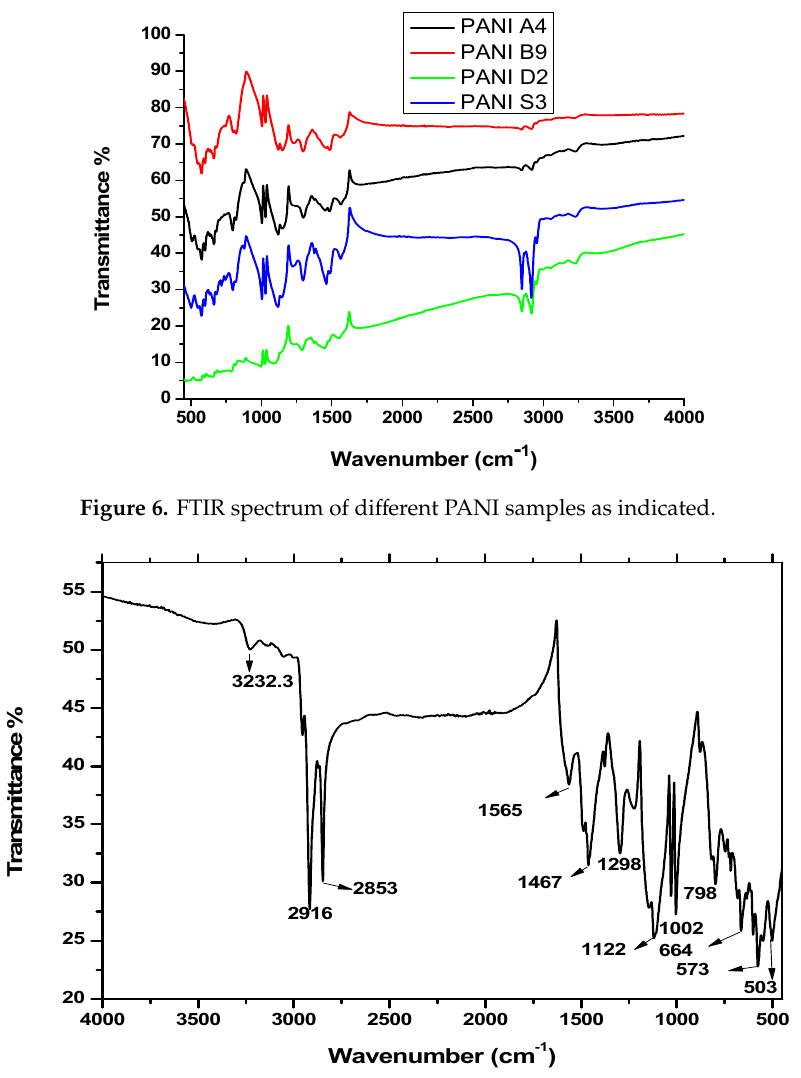
Figure 7. FTIR spectrum of PANI salt. Table 7. Peak assignments in the FTIR spectra of PANI salt.